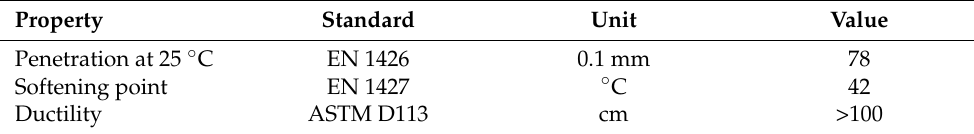
Table 3. The physical properties of plain